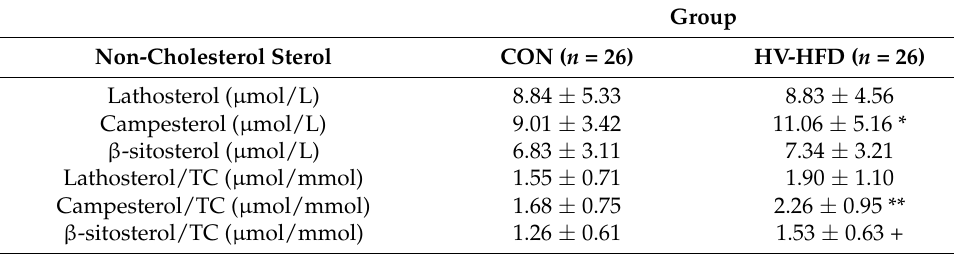
Table 2. Concentrations of non-cholesterol sterols in plasma.